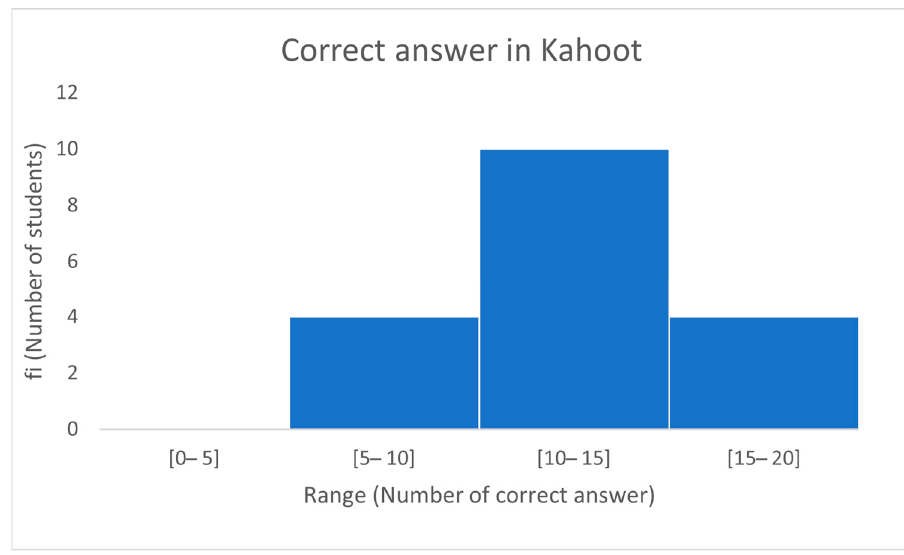
Figure 23. Correct answers in Kahoot! for each student or pair of students.